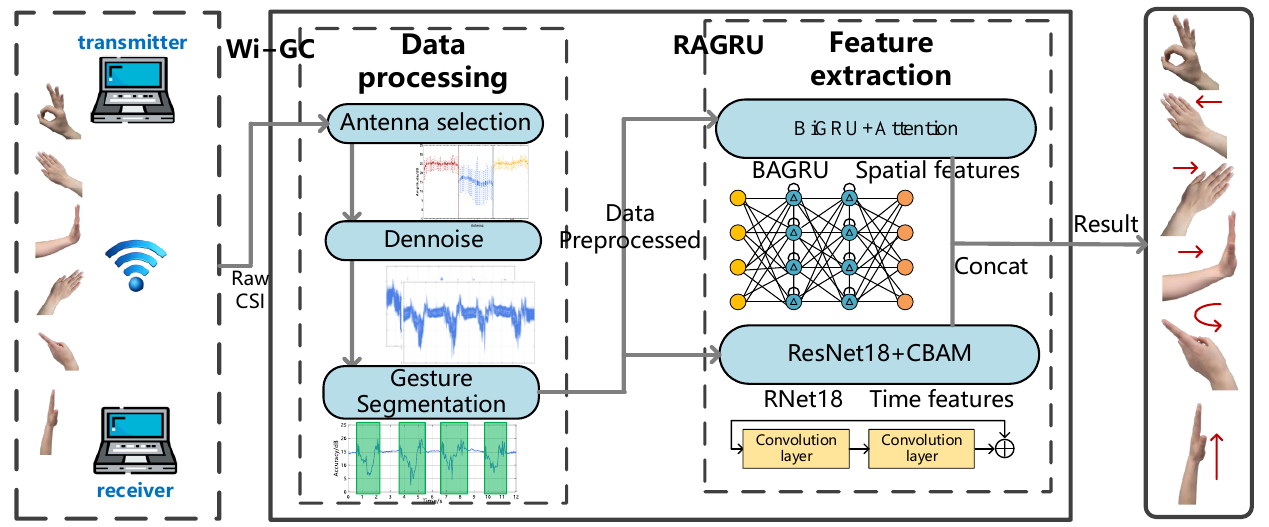
Figure 2. Flow chart of the Wi-GC method.